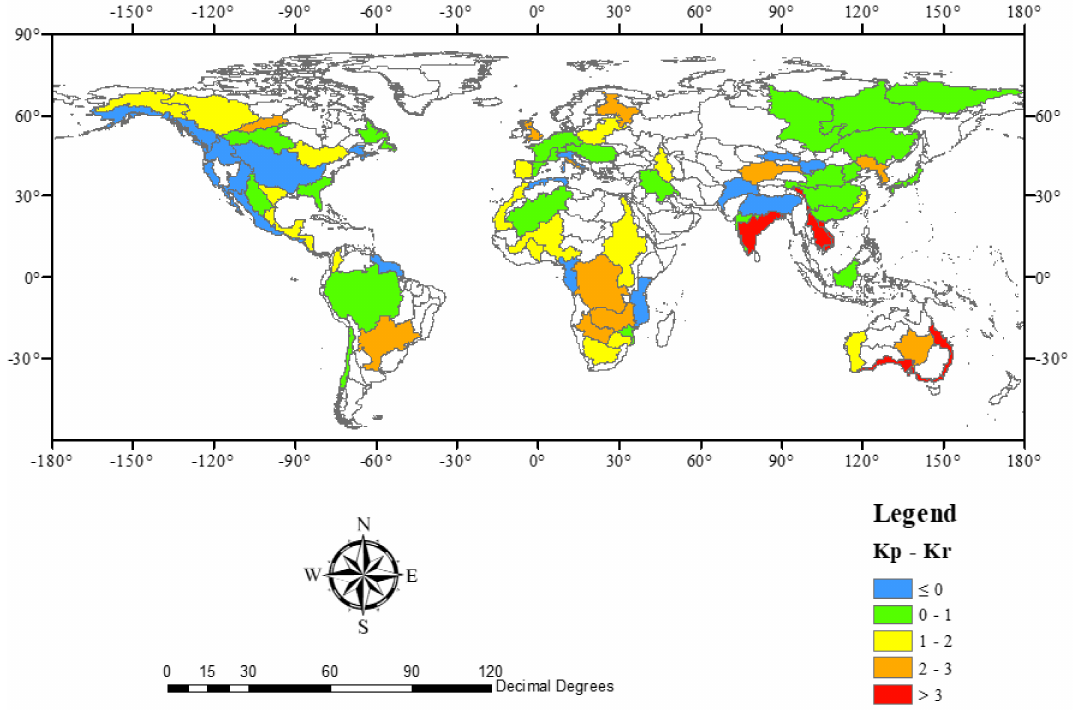
Figure 7. Global distribution of the di ff erence between the catchment scale meteorological line and river line. HydroSHEDS data was used as the boundary of catchments. Blank regions indicate there are no su ffi cient data to calculate the slope of both